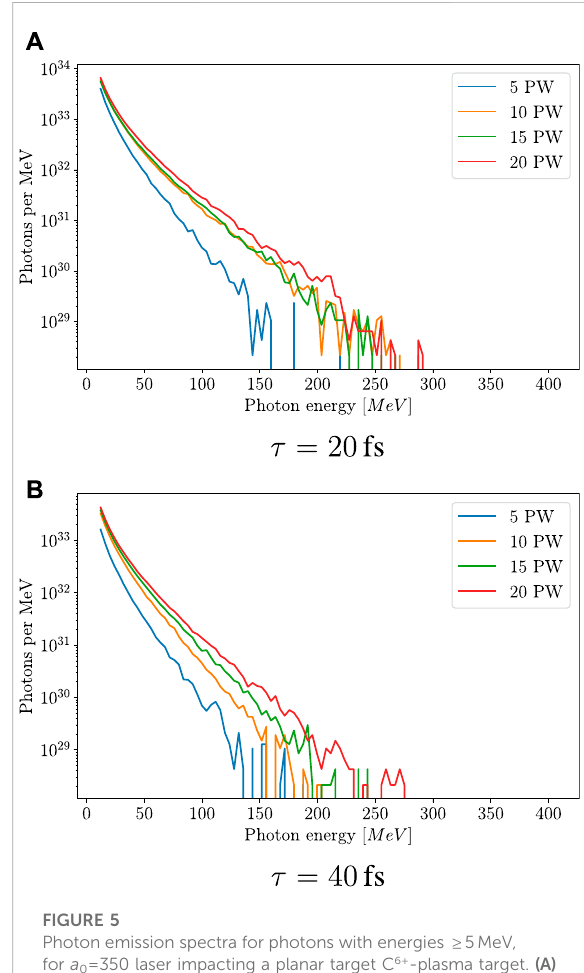
FIGURE 5 Photon emission spectra for photons with energies ≥ 5MeV,